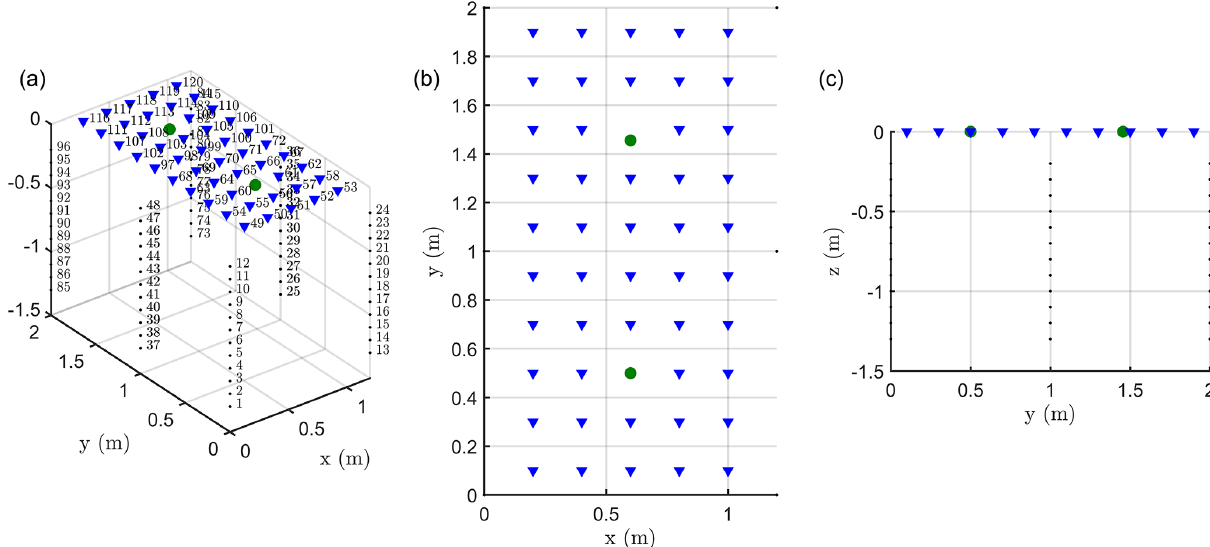
Figure A1. (a–c) Three-dimensional view of the surface (blue) and borehole (black) electrodes; view from the top and transversal view. Plant A was located downhill. Green dot shows plant stem positions.